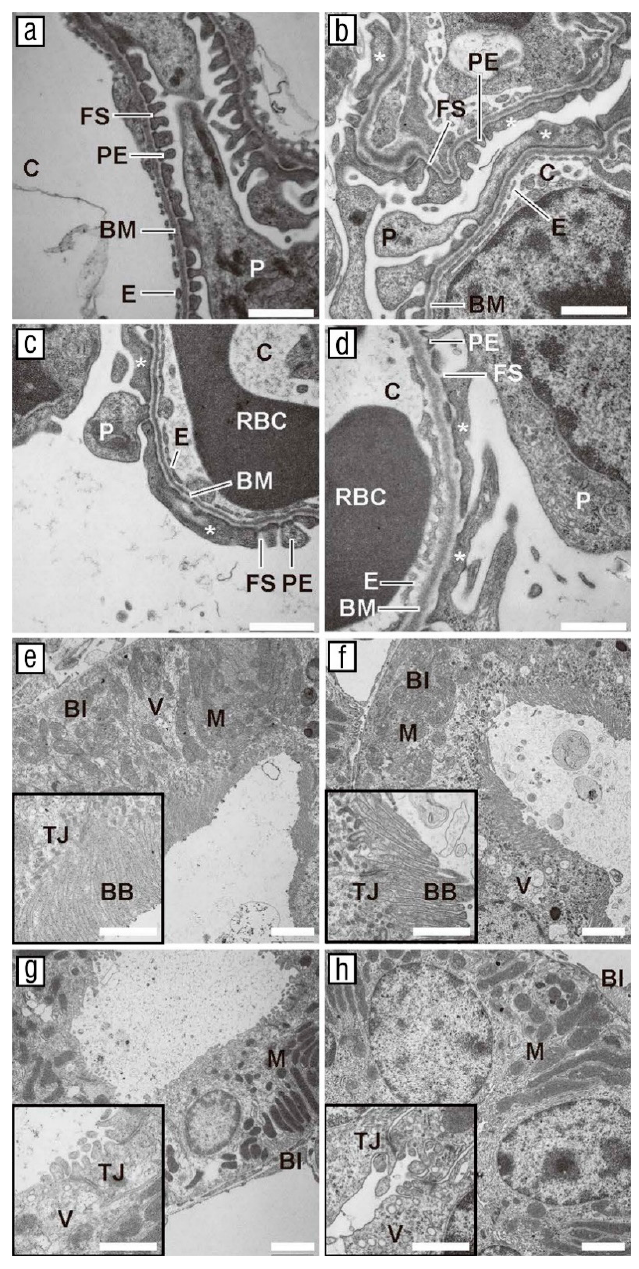
Figure 2. Transmission electron microscope (TEM) microphotographs of wild-type and yotari kidneys. Glomeruli of wild-type animals ( a ) showed a normally developed filtration barrier with fenestrated endothelium (E) of the capillary (C), basement membrane (BM), podocytes (P) with pedicles (PE), and filtration slits (FS). In the kidneys of yotari animals, effacement of the pedicles and lack of filtration slits could be noticed (asterisks, b – d ). No abnormalities were noticed in the proximal convoluted tubules (PCT) or distal convoluted tubules (DCT) of yotari mice compared to the wild-type animals ( e – h ). In the PCT, the cytoplasm was abundant, containing well-distinguished nuclei (N), elongated mitochondria (M), basal infoldings (BI), and many tubular pits (TP) between microvilli, which formed a brush border (BB) at the apical membrane ( e , f ). Higher magnification revealed the apical surface of PCT epithelial cells containing long microvilli to form the brush border and tight junctions (TJ) between the luminal cell borders of neighboring tubular epithelial cells ( e – f ). On the other hand, the apical surface of DCT epithelial cells containing few short microvilli and numerous vesicles ( g – h ). The scale bar in images ( a – d ) and insets ( e – h ) is 1 µm; the scale bar in images ( e – h ) is 2 µm.